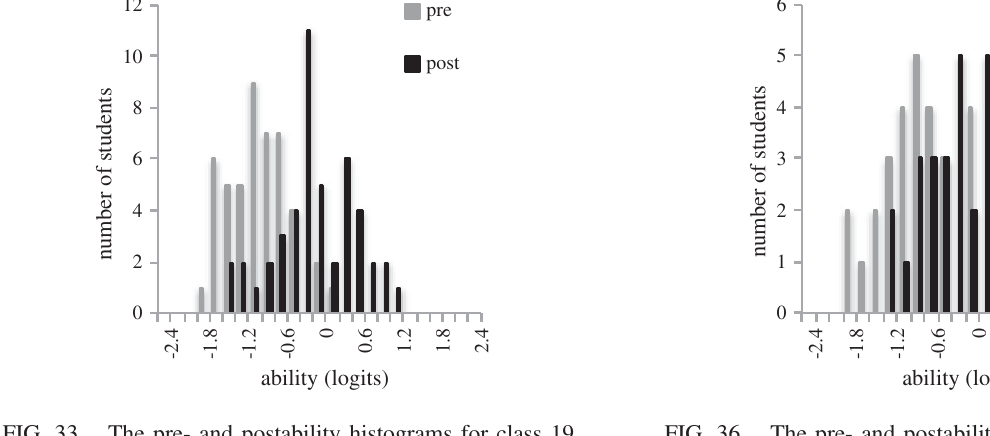
FIG. 33. The pre- and postability histograms for class 19.